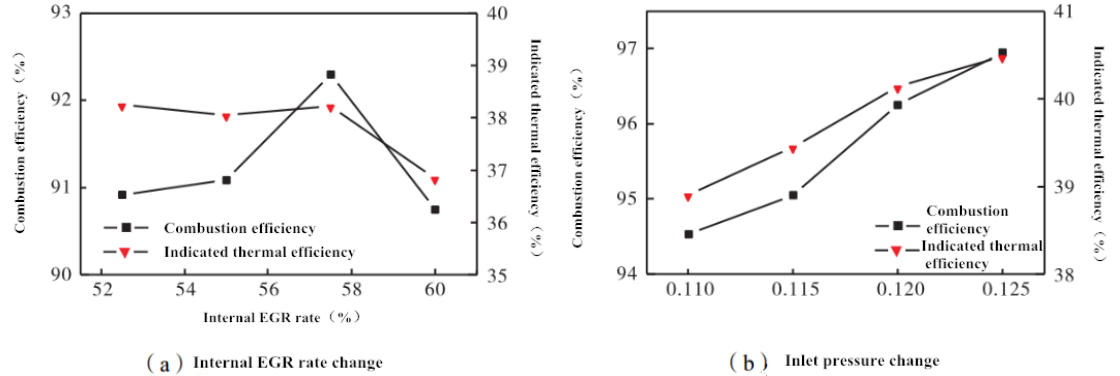
Fig. 14 Effect of EGR rate and intake pressure on combustion efficiency and indicated thermal efficiency